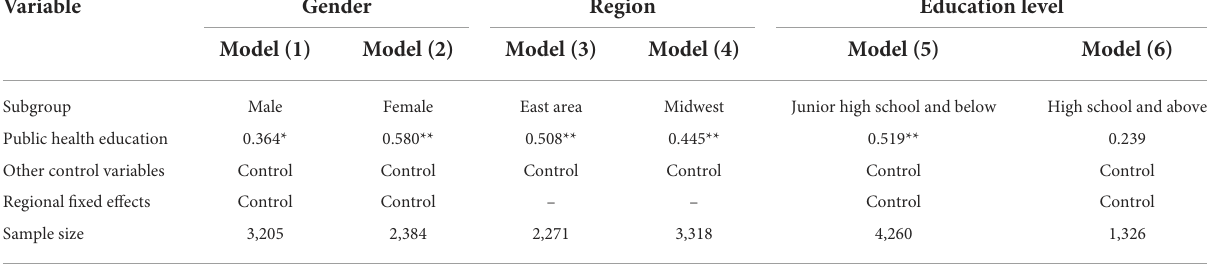
TABLE 5 Variable error reduction.